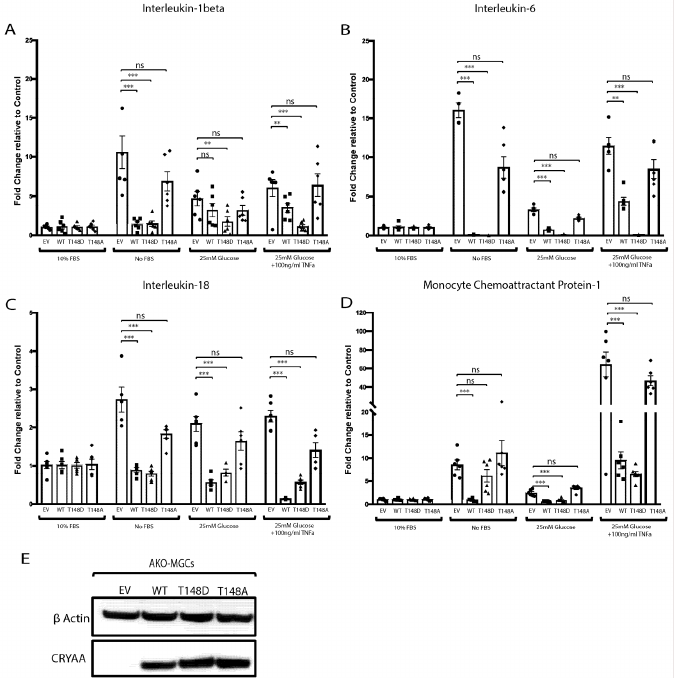
Figure 3. Primary MGCs (HspB4 − / − ) express pro-inflammatory molecules upon stress exposure, which is modulated by HspB4/ α A-crystallin. Primary Müller cells (HspB4 − / − ) were transfected with either empty vector (EV), wild-type HspB4/ α A-crystallin (WT), phosphomimetic form of HspB4/ α A-crystallin (T148D), or non-phosphorylatable form of HspB4/ α A-crystallin (T148A). Then, 24 h post transfection, cells were either exposed to normal media (10% FBS), serum starvation (no FBS), high glucose (25 mM glucose), or to diabetic-like stress (25 mM glucose + 100 ng/mL TNF α ) for 4 h. The mRNA levels of ( A ) interleukin-1 beta, ( B ) interleukin-6, ( C ) interleukin-18, and ( D ) monocyte chemoattractant protein-1 were normalized to the actin-encoding gene Actb . ( E ) Representative immunoblot depicting the expression of HspB4/ α A-crystallin in transfected MGCs (HspB4 − / − ). ** p ≤ 0.01, *** p ≤ 0.001, significantly different from the respective EV-transfected cells. The primary Müller cells (HspB4 − / − ) were used up to passage 4 for the experiments. Each endpoint was measured on a minimum of six technical replicates in three independent experiments. Statistical analysis was performed by one-way ANOVA followed by Student–Newman–Keuls